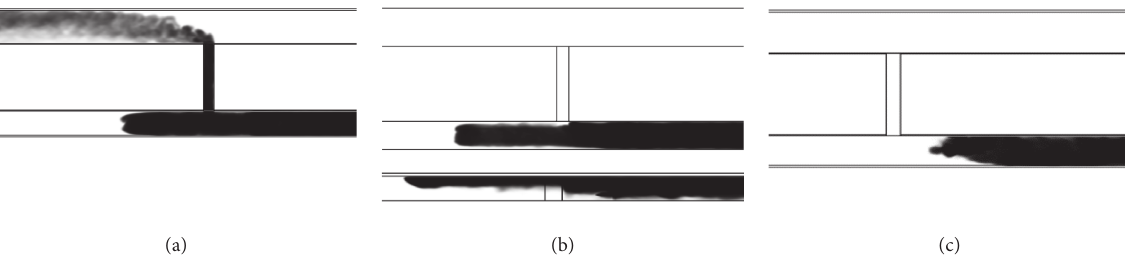
Figure 7: (a) Smoke diffusion at 300s of scheme 2. (b) smoke diffusion at 300s of scheme 3. (c) smoke diffusion at 300s of scheme